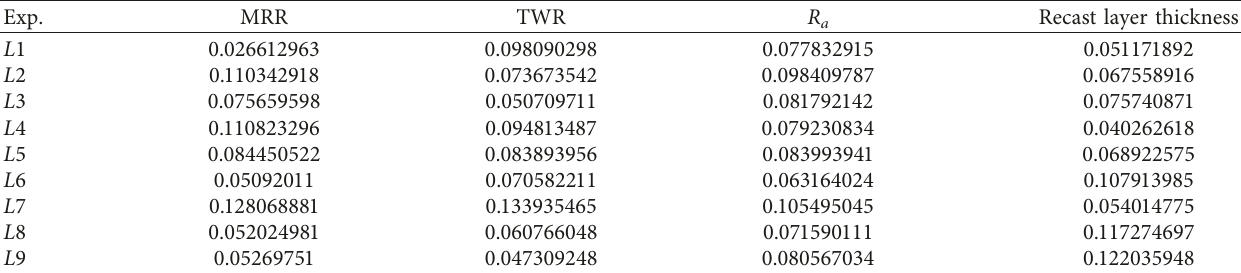
Table 7: Weighted normalized matrix.